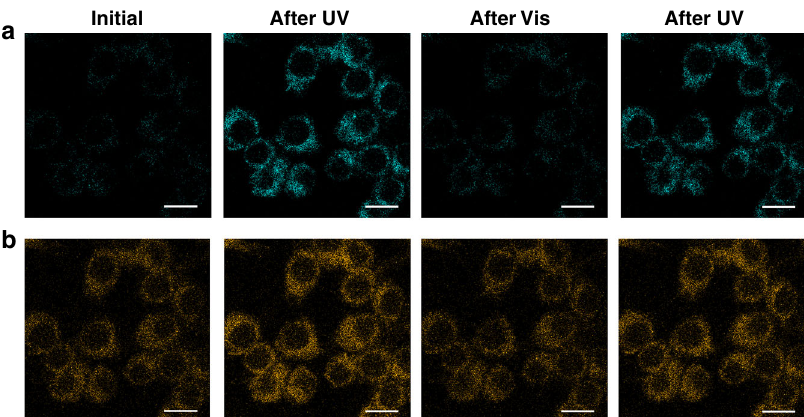
Fig. 7 Bioimaging. Confocal microscopy images (scale bar: 10 μ m) of the RAW264.7 cells incubated with the PCL nanoparticles for 1 h: ( a ) Blue emission channel (460 – 500 nm), and ( b ) orange emission channel (600 – 780 nm)